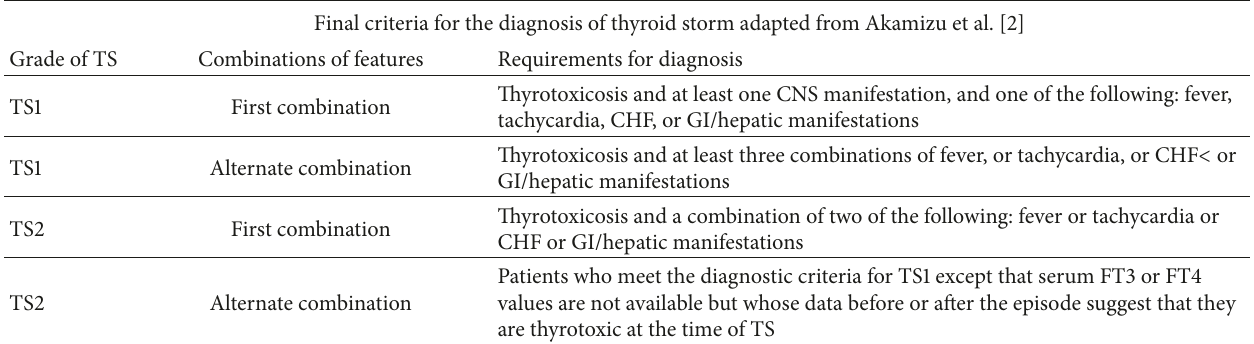
Table 2: Diagnostic criteria of thyroid storm established by the Japan Thyroid Association. Final criteria for the diagnosis of thyroid storm adapted from Akamizu et al.